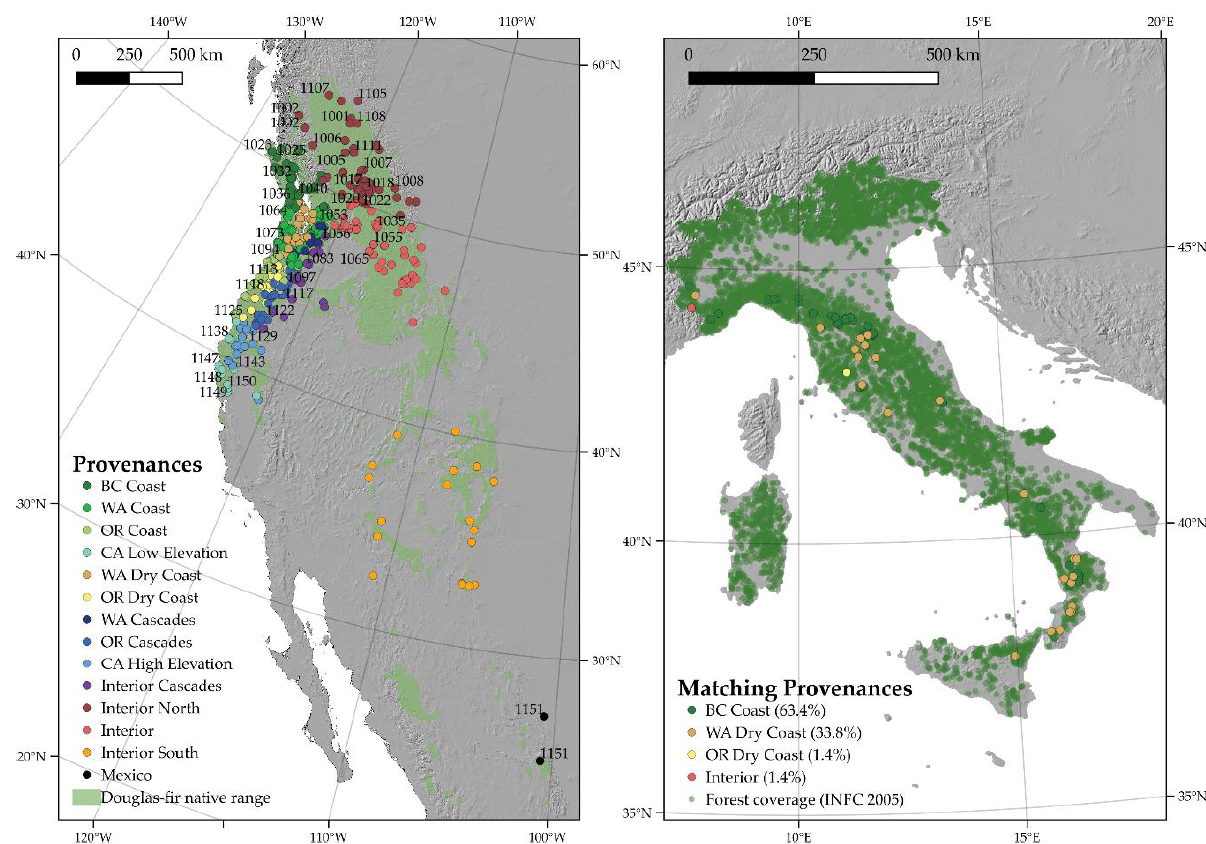
Figure 3. Climate matching between the PNW and the 1961 – 1990 normal climate in Italy and proportion of the Italia stands occupied by each bioclimatic group in the PNW. Only groups with 1 stand, at least, are reported in the legend of the Italy map.